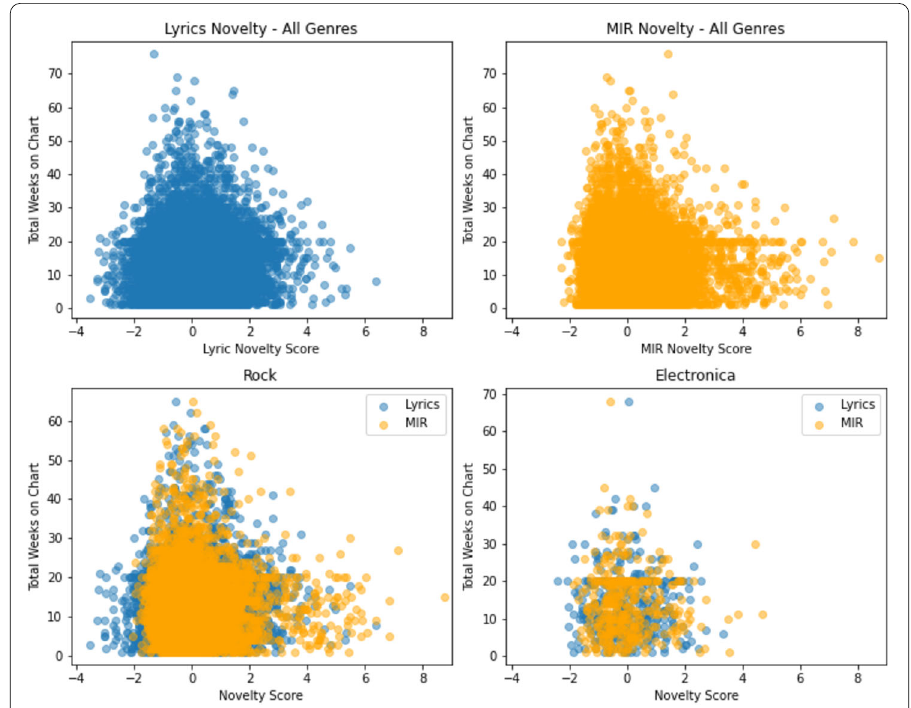
Figure 4 Joint distributions of song novelty scores and total number of weeks the song spent on the chart. Top row shows the joint distributions for all genres. Bottom row shows the overlay of MIR-total weeks joint distribution and lyrics-total weeks joint distribution for Rock, and Electronica. In each distribution we can see that the highest number of total weeks on chart occur within a certain range of novelty